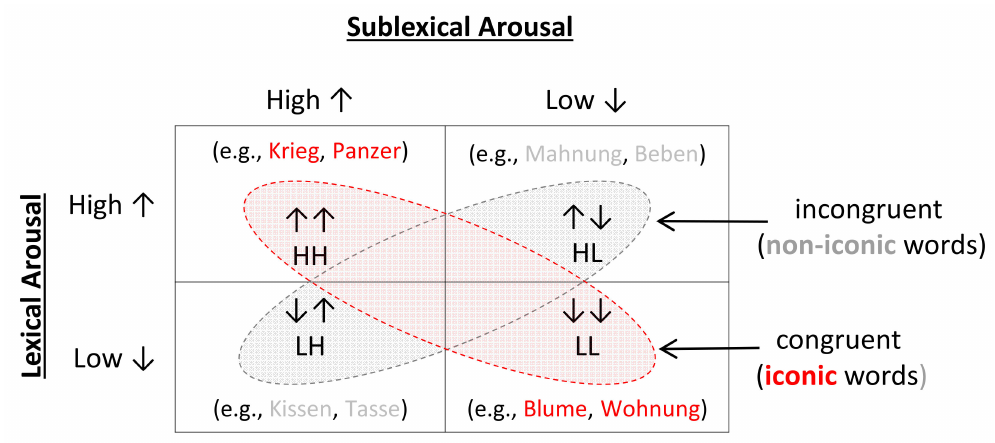
Figure 1. Words were organized in a 2 × 2 design with each of experimental factors ( lexical arousal and sublexical arousal ) manipulated in two distinct groups consisting of extreme levels of arousal (High = exciting, and Low = calming). The congruence vs. incongruence of lexical arousal (meaning) and sublexical arousal (sound) resulted in two groups of iconic vs. non-iconic words, respectively. Two example words (in German) from each category are given in each cell.